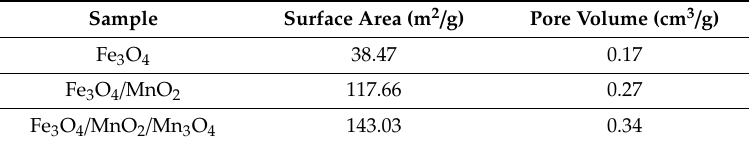
Figure 5. N 2 adsorption–desorption isotherms of hollow Fe 3 O 4 microspheres ( a ), hollow flower-like Fe 3 O 4 / MnO 2 microspheres ( b ), and hollow flower-like Fe 3 O 4 / MnO 2 / Mn 3 O 4 photocatalyst ( c ). Insets in ( a – c ) are the corresponding pore width distribution plots. Table 1. Physical parameters of the prepared